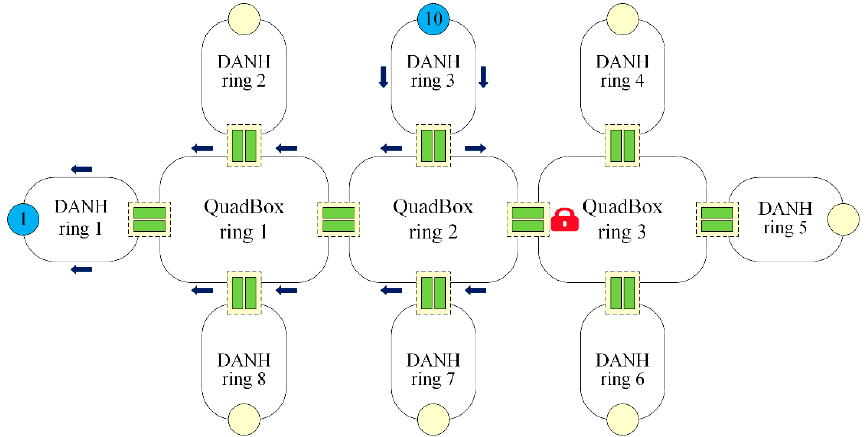
Figure 7. Using the first replied frame to discover passive QuadBox rings in eEFA.